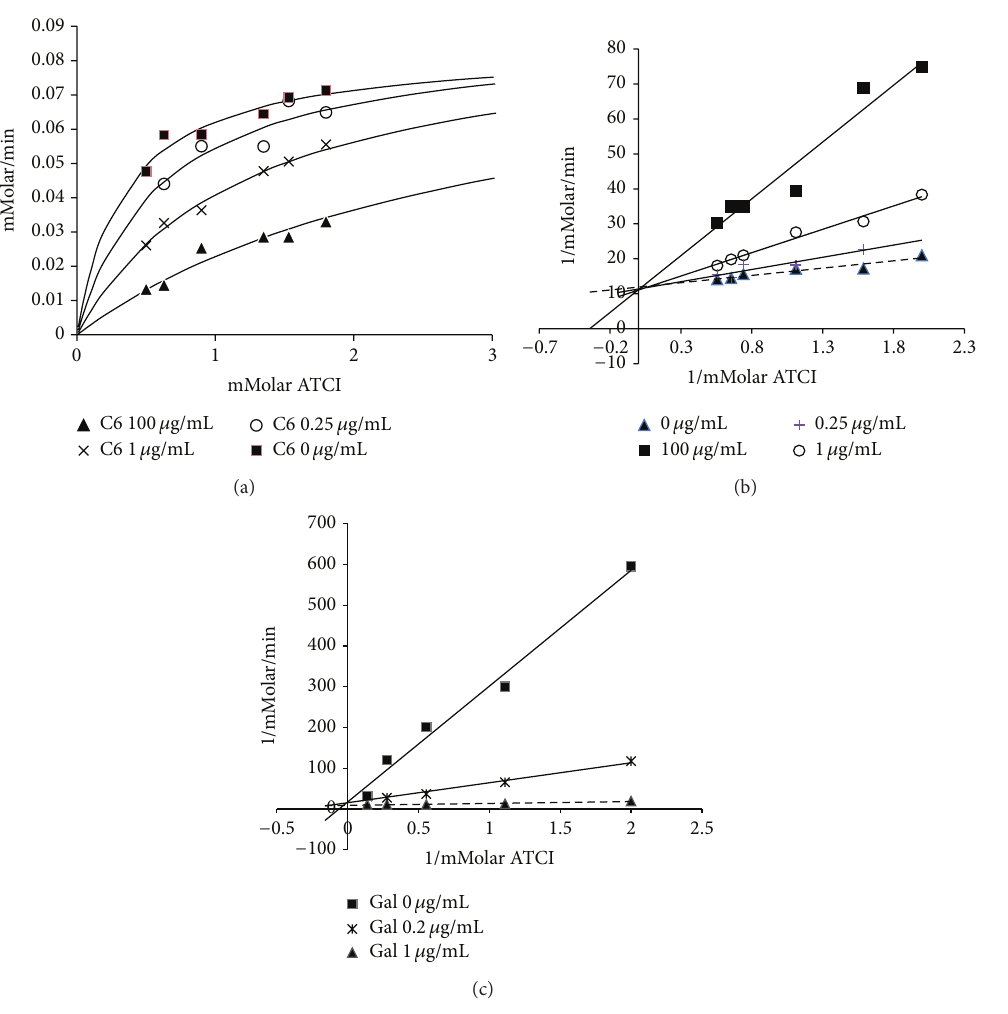
Figure 5: Kinetic study of inhibition of acetylcholinesterase by C6 fraction and galantamine (standard acetylcholinesterase inhibitor). (a) Michaelis-Menten kinetic for C6 fraction, (b) double reciprocal (Lineweaver Burk) plot for C6 fraction, and (c) double reciprocal (Line- weaver Burk) plot for